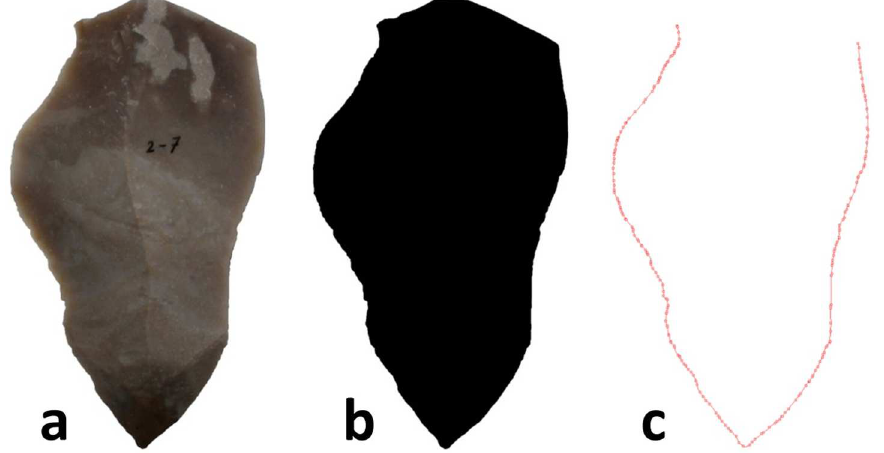
Fig 1. Demonstration of the method used to measurecutting edge length, showing a photograph of an original blank (a), and two stages in the process of reducing the photograph to a measurable polygon (b and c). Note the platform is excludedin the polygonmeasurement so as to measurepossible cutting edge